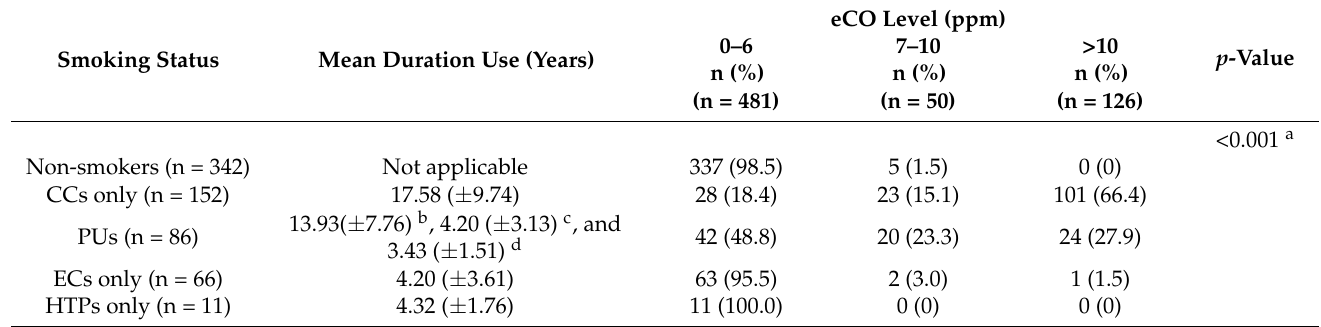
Table 4. Exhaled CO level categories according to users and